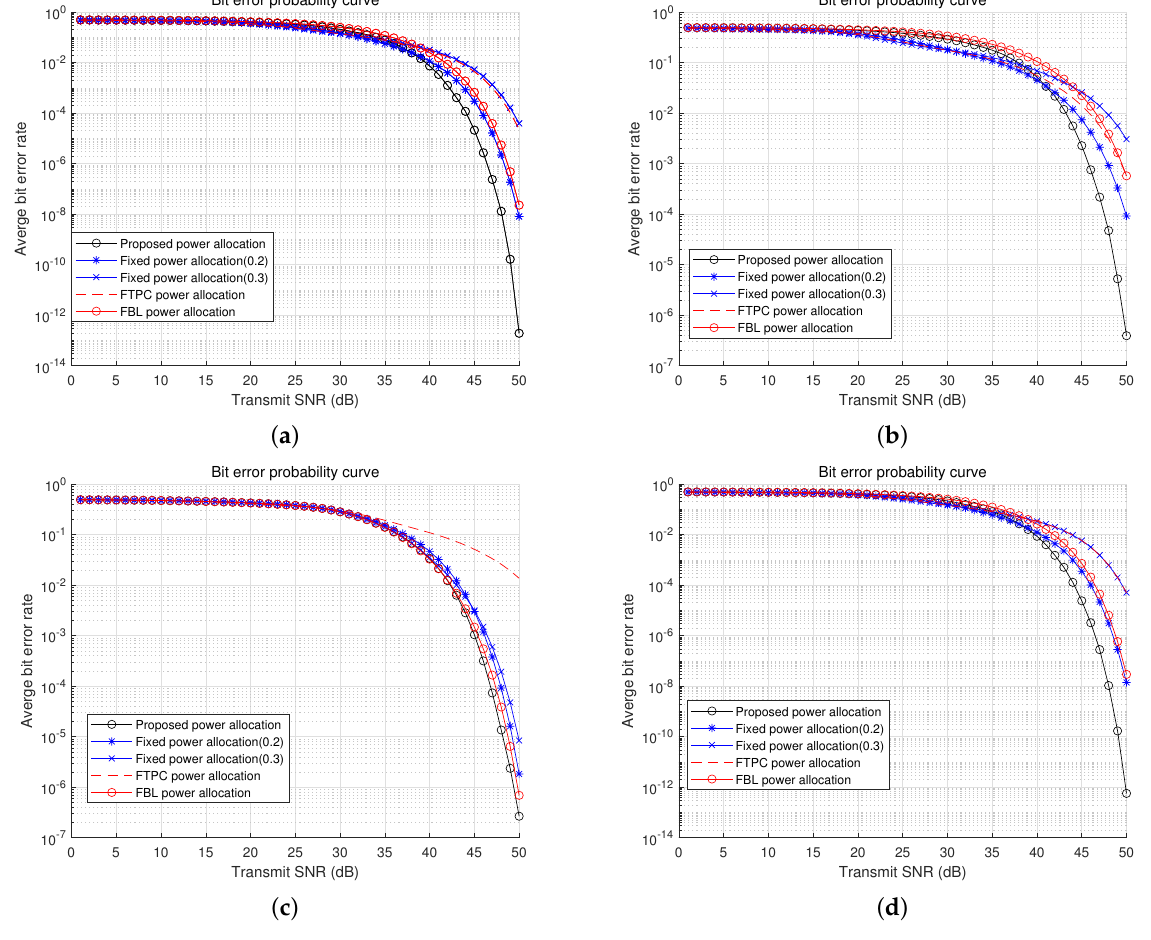
Figure 9. BER comparisons ( a ) BER comparison ( h f = 0.0251, h n = 0.4010). ( b ) BER comparison ( h f = 0.0402, h n = 0.3675). ( c ) BER comparison ( h f = 0.0445, h n = 0.1002). ( d ) BER comparison ( h f = 0.0395, h n =